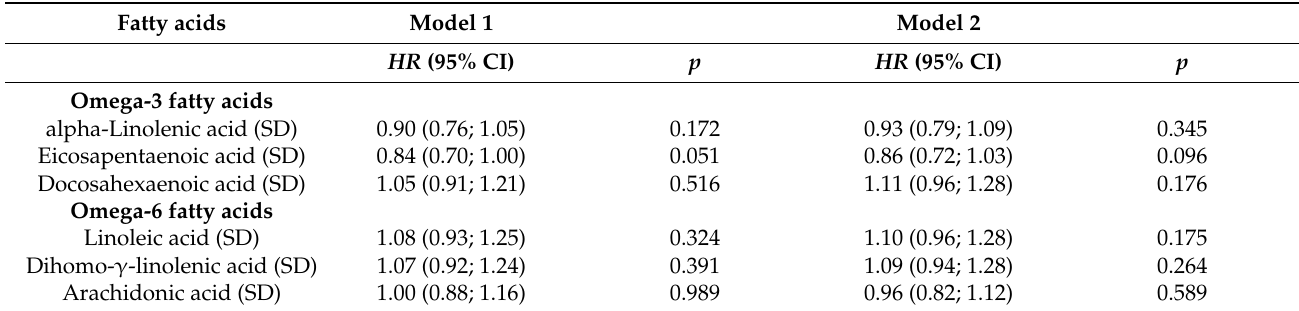
Table 6. Longitudinal associations between percentage n-3 and n-6 fatty acids in serum phospholipids and incident AD dementia over a 7-year follow-up period ( n =